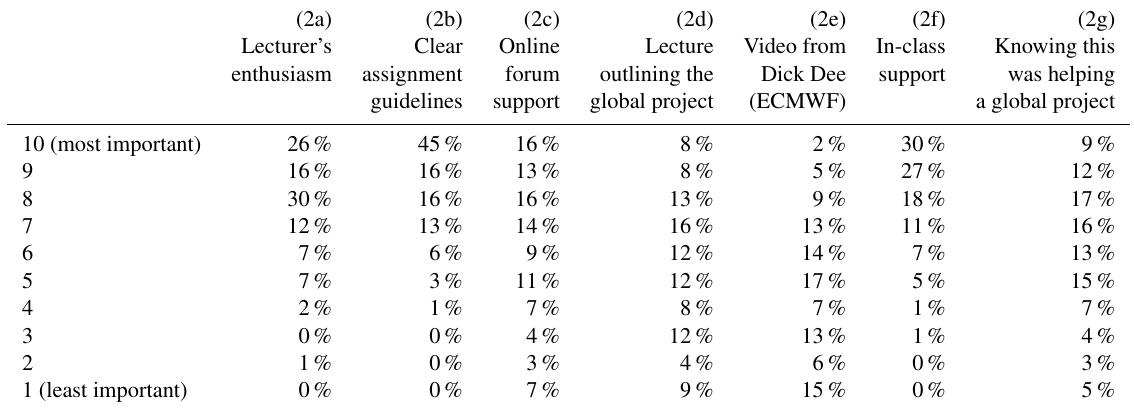
Table 2. Results of question 2 (a–g) of the survey which asked students to give a score from (1–10) to a list of items, indicating how important each item was in enabling them to successfully complete the assignment. The table shows the percentage of the 152 responses to each question. (1 being least important and 10 being most